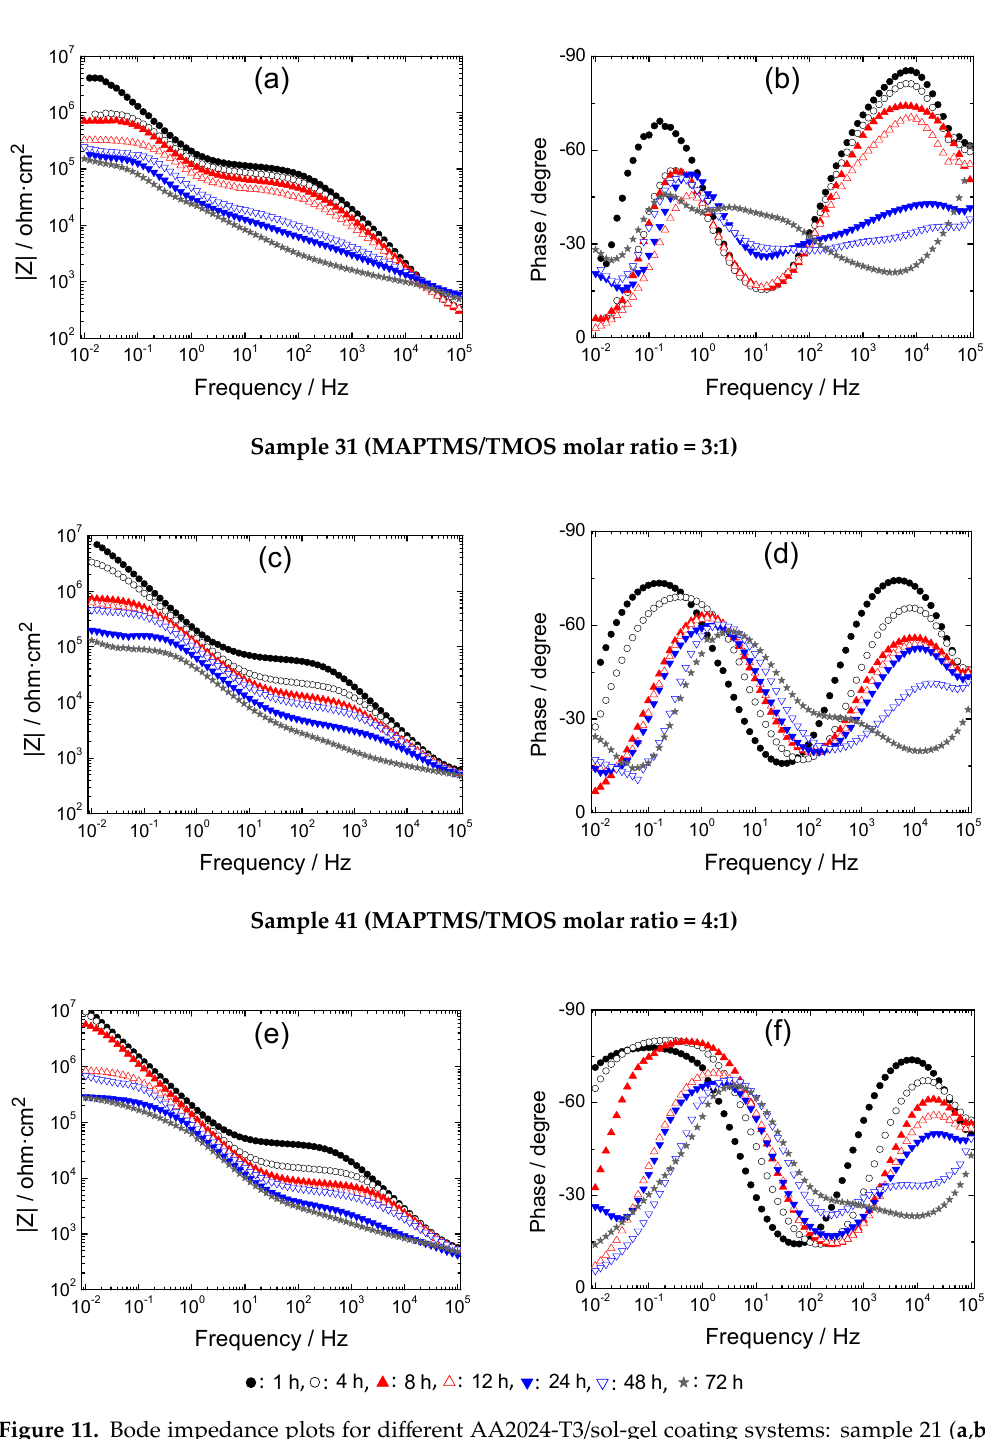
Figure 11. Bode impedance plots for di ff erent AA2024-T3 / sol-gel coating systems: sample 21 ( a , b ), sample 31 ( c , d ) and sample 41 ( e , f ). Test electrolyte: 0.05 M NaCl aqueous solution. Immersion time: 1 h, 4 h, 8 h, 12 h, 24 h, 48 h and 72